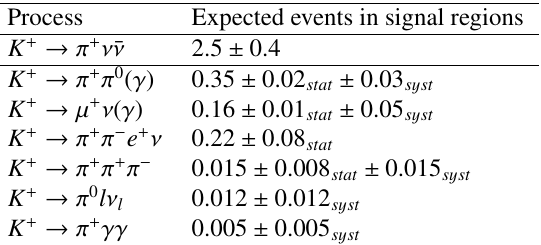
Table 1. Expected number of signal and background events in the signal